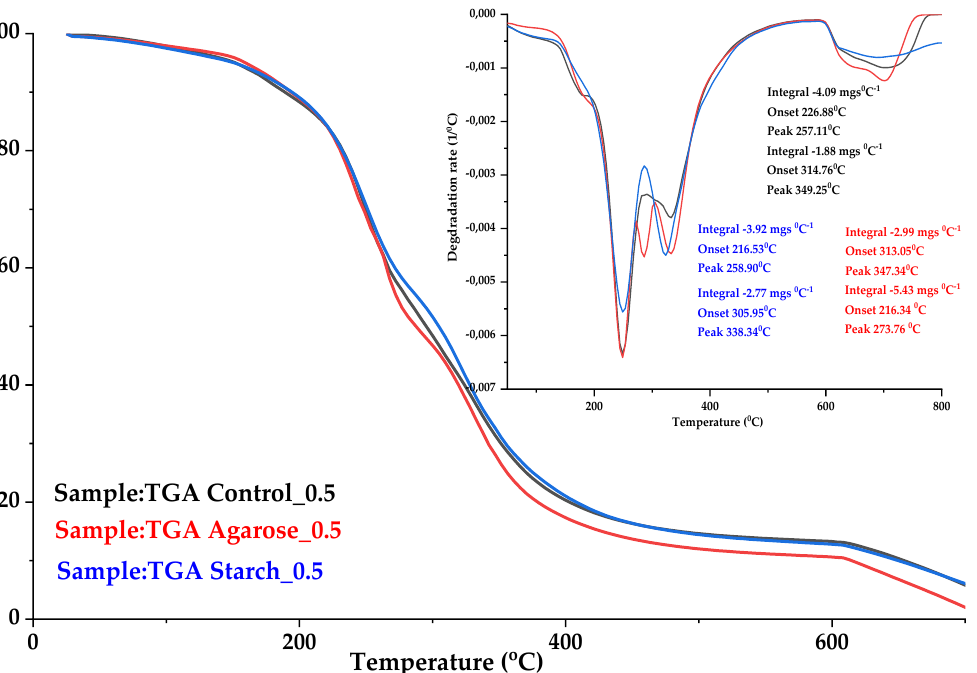
Figure 6. Thermogravimetric analysis curves (TGA) of gelatin samples: Control_0.5 (black curve); Agarose_0.5 (red curve); Starch_0.5 (blue curve).